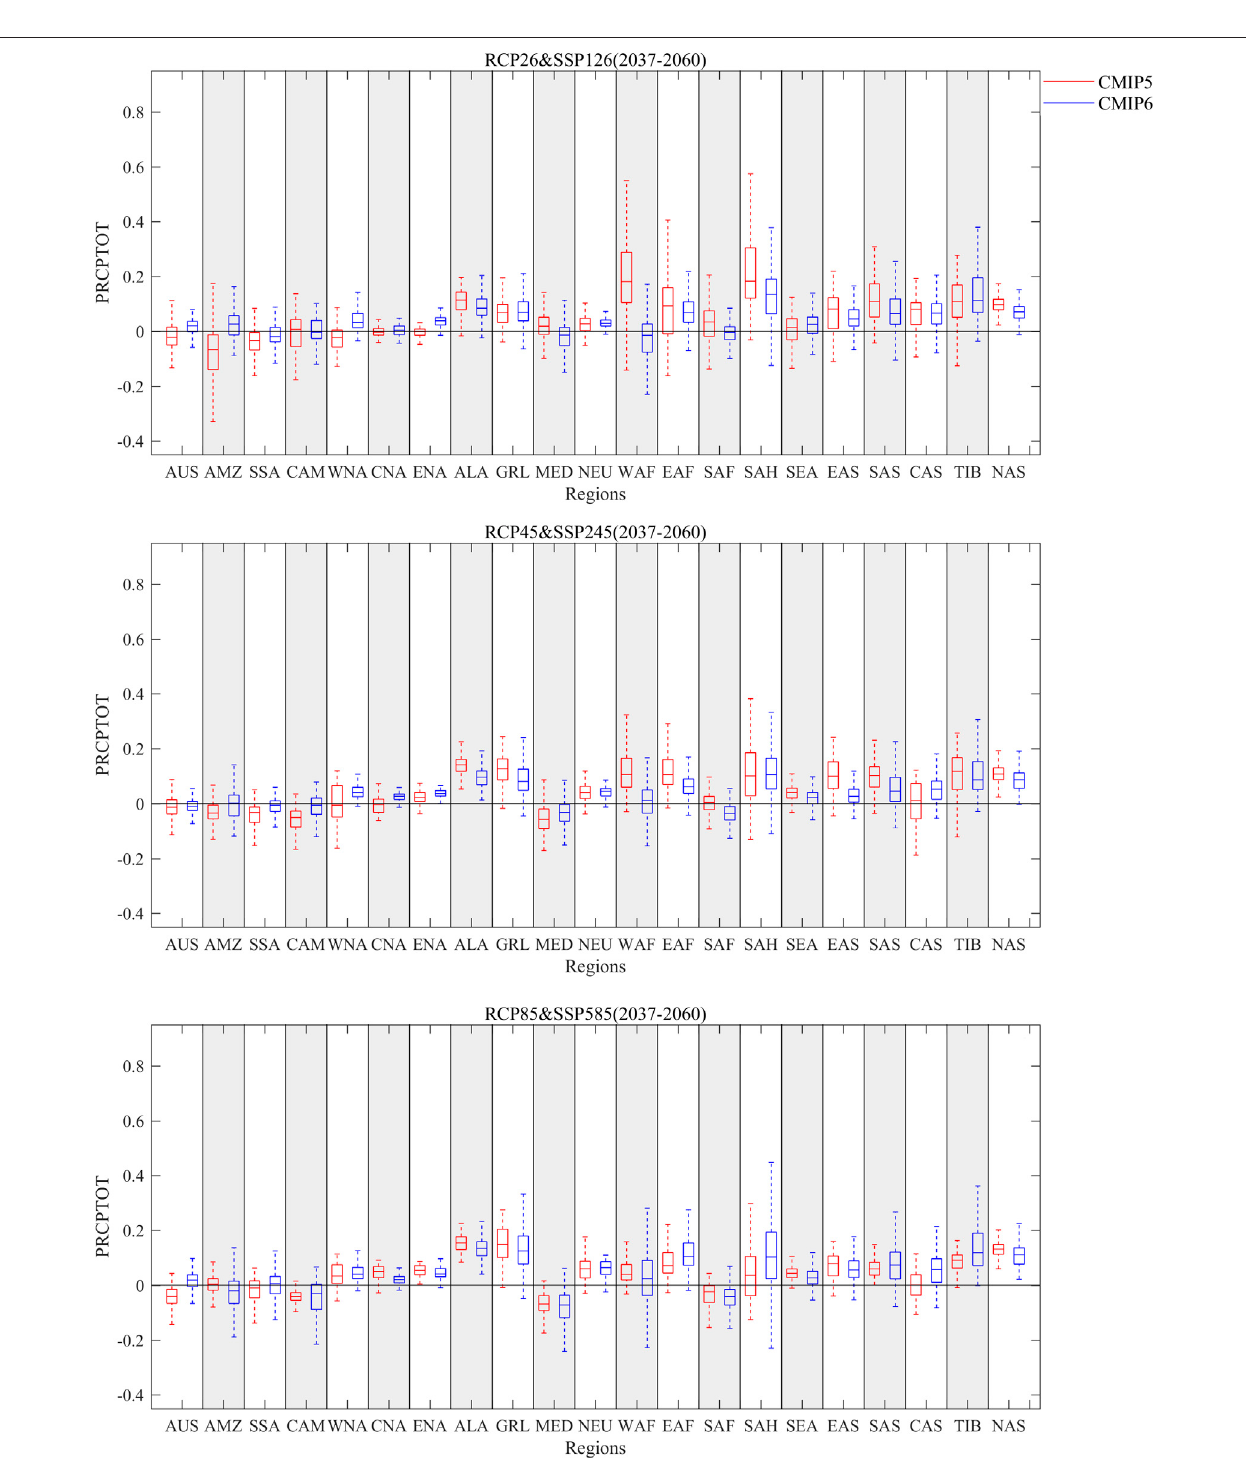
FIGURE 7 | Box plots for PRCPTOT multi-model mean changing rates in 21 regions in near-future period (2028 – 2060) over the historical period (1982 – 2005) in CMIP5 and CMIP6. CMIP5 is presented in red and CMIP6 is presented in blue.